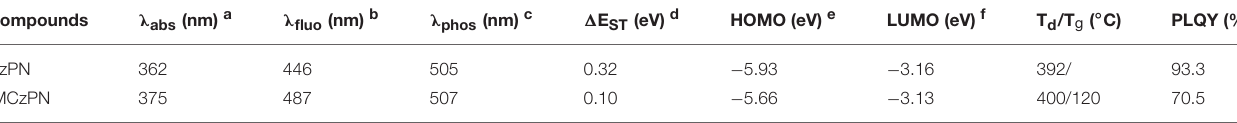
TABLE 1 | Key physical properties of two compounds.